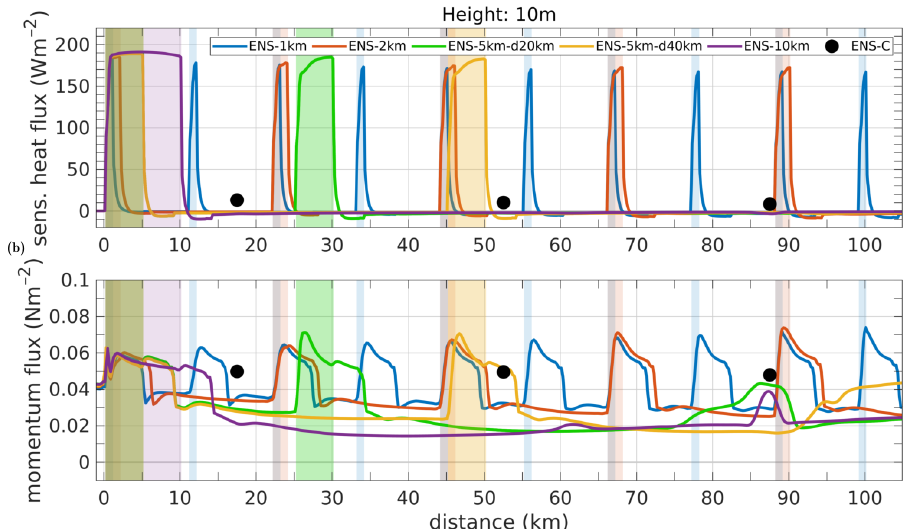
Figure 4. Fluxes of sensible heat ( a ) and momentum ( b ) at height z = 10m as a function of distance obtained by the model runs NL-M20-zi for the lead-resolving cases (ENS-1km, ENS-2km, ENS-5km- d20km, ENS-5km-d40km, ENS-10km), and by the model run NL-LS96-zi for case ENS-C. Cases and model runs are described in Figure 2 and Table 1 (see Section 2). The colored rectangles denote the positions of the leads. The flow is from left to right. Modified based on Michaelis [1].